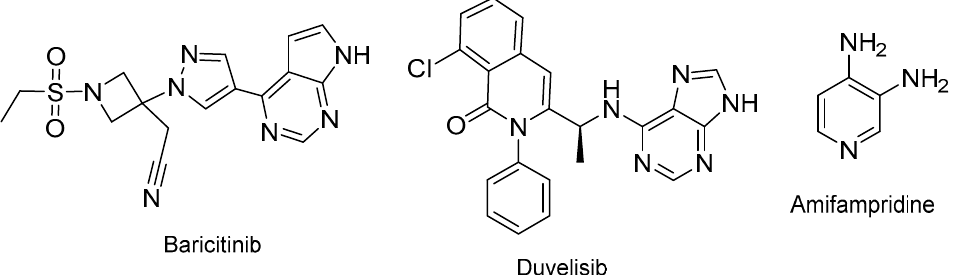
Figure 20. Structure of baricitinib, duvelisib, and amifampridine.